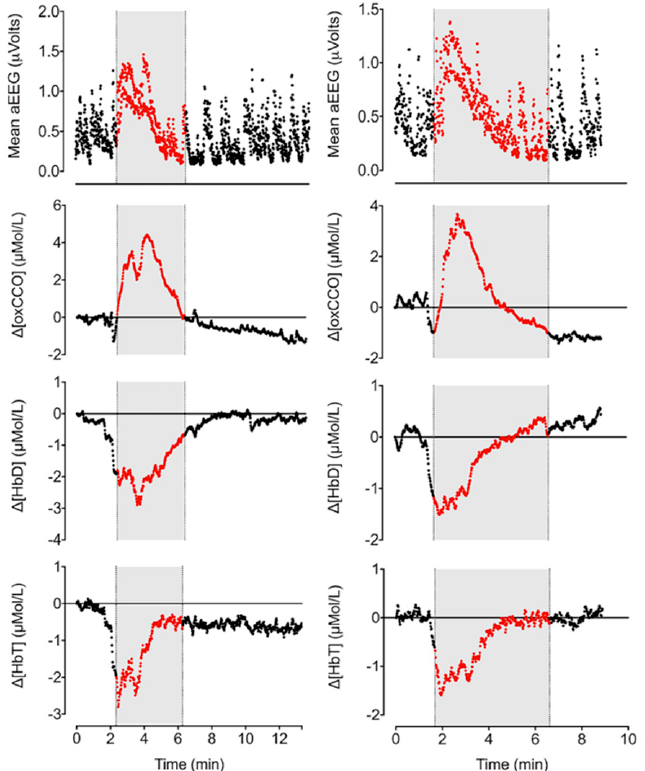
Figure 2. Changes in cerebral metabolism (oxCCO), oxygen delivery (HbD) and blood volume (CBV) during seizures in an infant with HIE (left = seizure 4 of 5, right = seizure 5 of 5). Seizure periods were identified on raw EEG and are marked here in grey [46] (reproduced with permission under the Creative Commons Attribution 4.0 International License (http://creativecommons.org/licenses/by/ 4.0/, accessed on 26 June